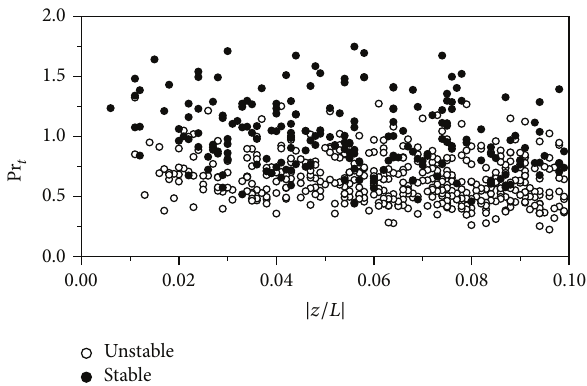
Figure 4: The scatter plot of the turbulent Prandtl number (Pr 𝑡 ) against |𝑧/𝐿| ≤ 0.1 with 𝑘 = 0.396 .